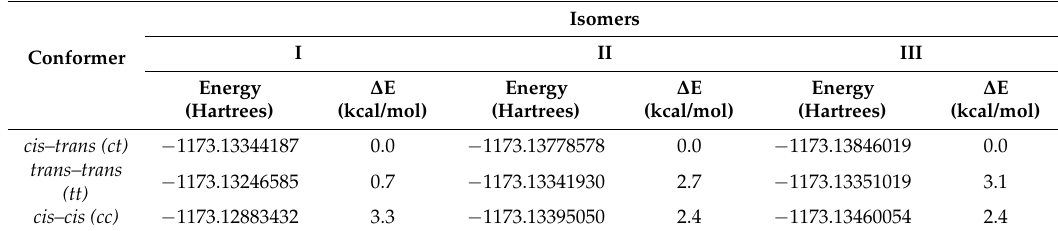
Table 1. Conformational energy values for I – III .